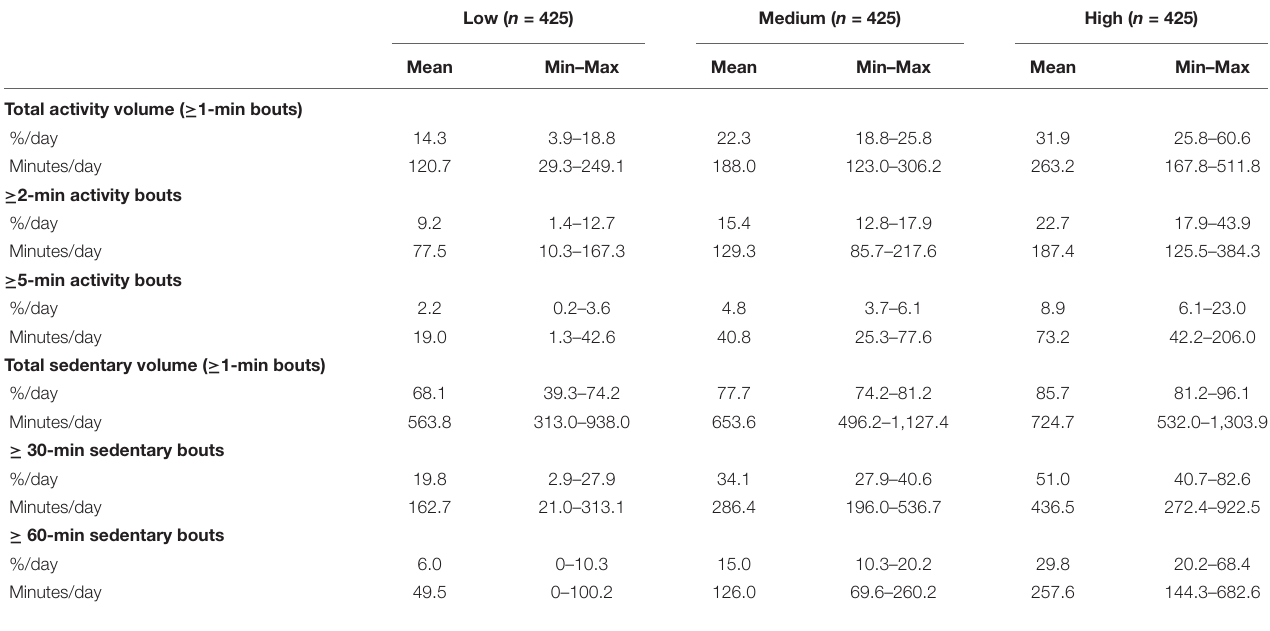
TABLE 2 | Descriptive means and ranges of daily accelerometer metrics by bout-specific tertiles of either total or sedentary